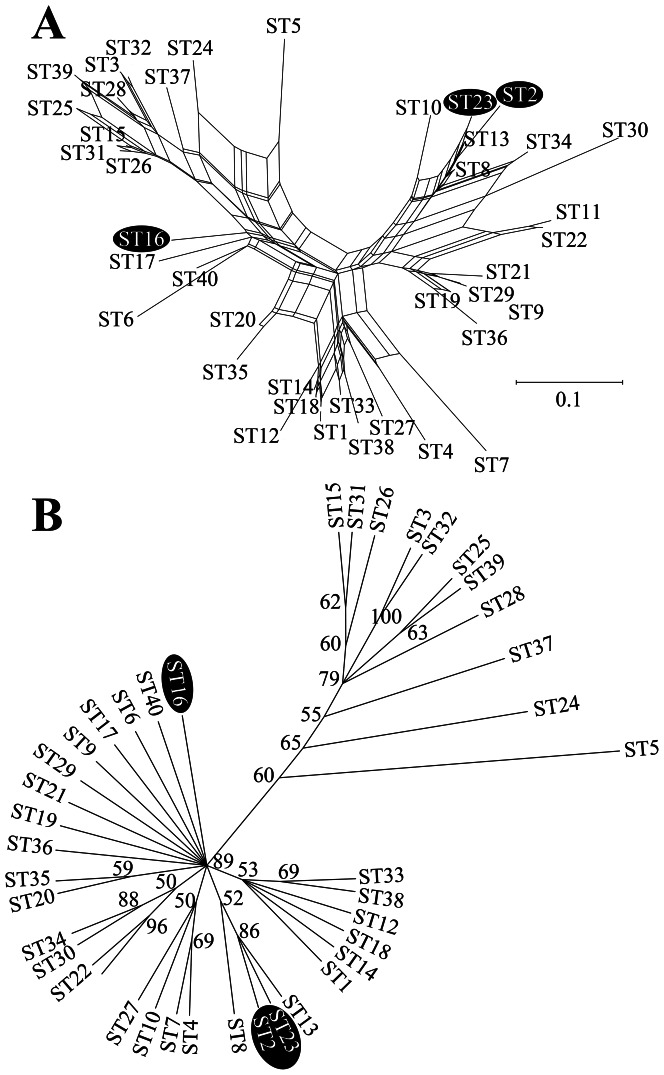
Phylogeny of sequence types (STs) based on neighbor-net (panel A) and ClonalFrame (panel B) algorithms.Numbers at nodes on the ClonalFrame tree are posterior probabilities >50/100. Highlighting indicates the three S. hominis subsp. novobiosepticus STs.